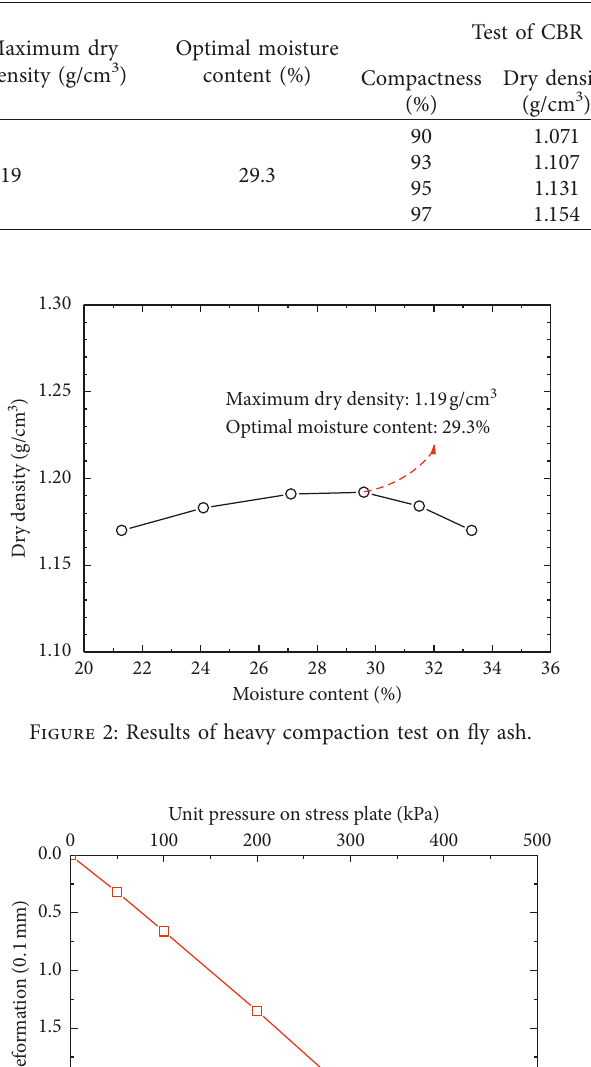
Table 2: Laboratory test results of fly ash.